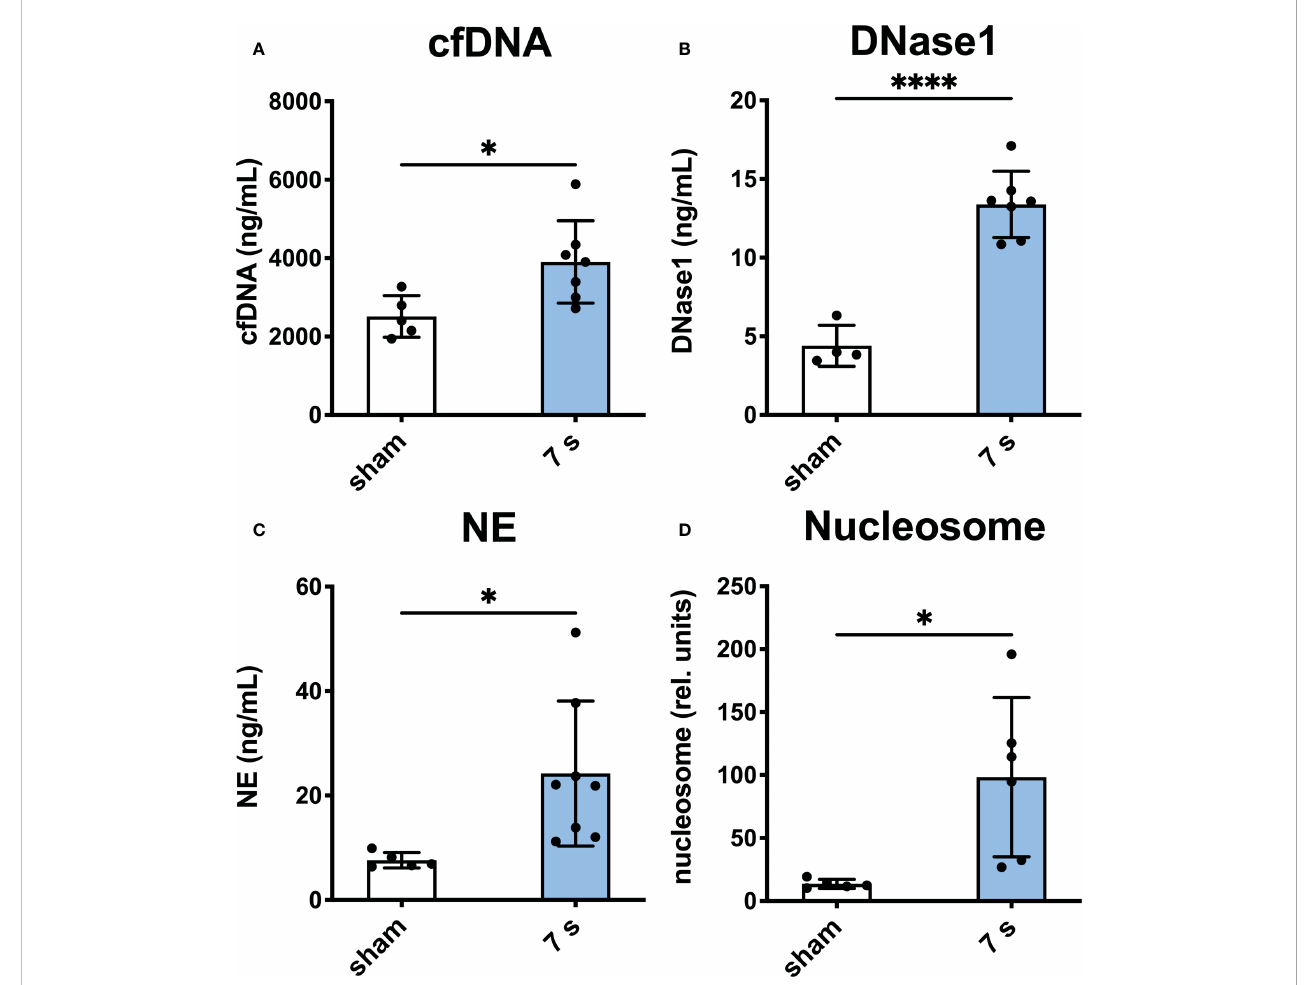
FIGURE 7 7 s scald leads to an upregulation of markers of neutrophil activation in plasma after 24 h. CfDNA assay (A) , DNase1 ELISA (B) , NE ELISA (C) , and nucleosome ELISA (D) are shown. Results are provided as mean ± SD. For comparison, an unpaired t-test was performed. The levels of signi fi cance: *p < 0.05; ****p <